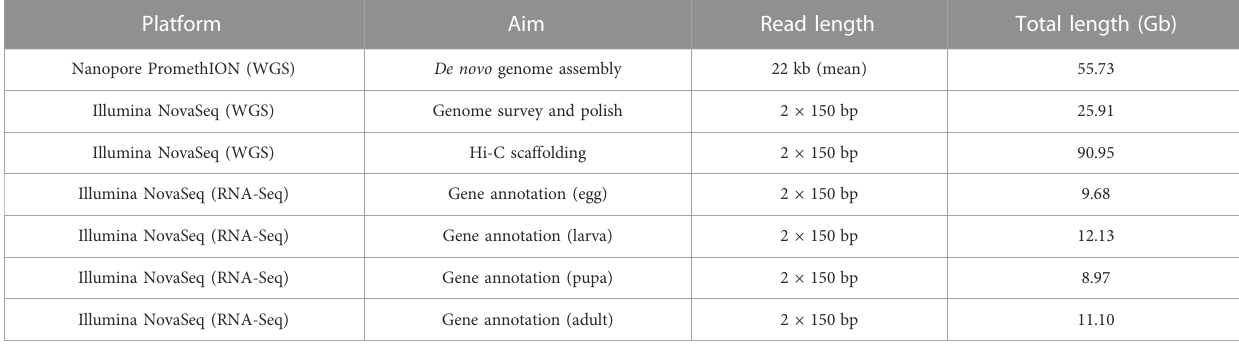
TABLE 1 Raw data of S. montelus generated in the present study using Nanopore and Illumina technology. Platform